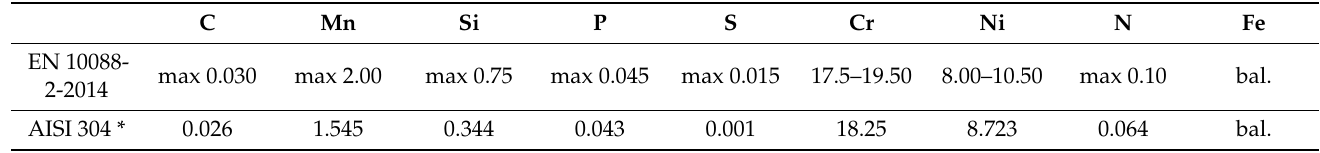
Table 1. Comparison measured and nominal chemical composition of AISI 304 (X5CrNi18-10) stain- less steel (mas. %).